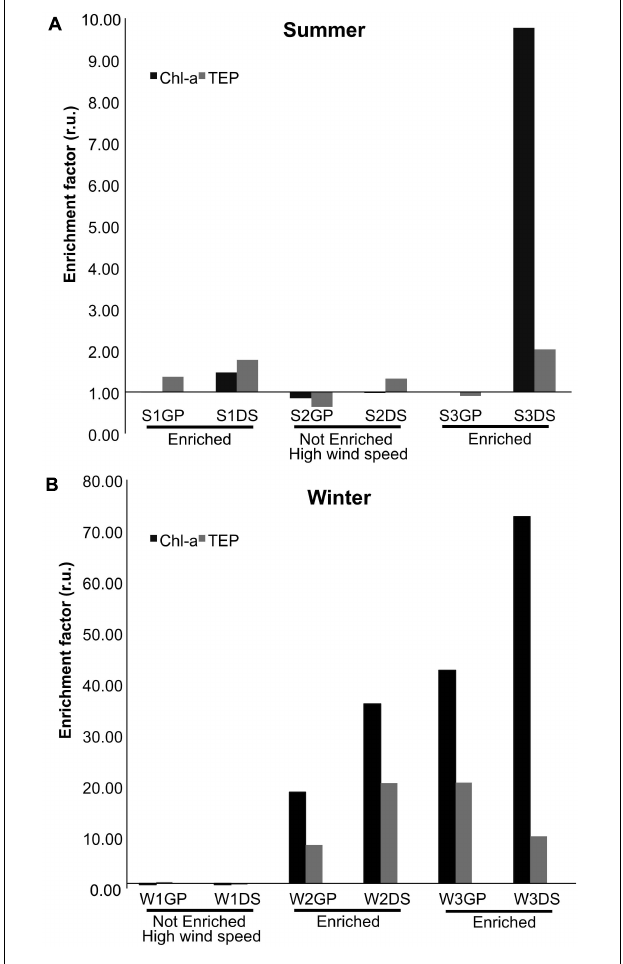
FIGURE 1 | Enrichment factors in relative units (r.u.) of chlorophyll-a (chl-a) and transparent exopolymer particles (TEP) in the SML compared with UW in samples collected using either glass plate (GP) or drum sampler (DS) samplers. (A) Summer sampling (S) and (B) winter sampling (W). A sampling period (e.g., S1, W2) was considered enriched when both TEP and chl-a, collected using either GP or DS, exceeded 1.0. Note that the y -axis scales of (A,B) are